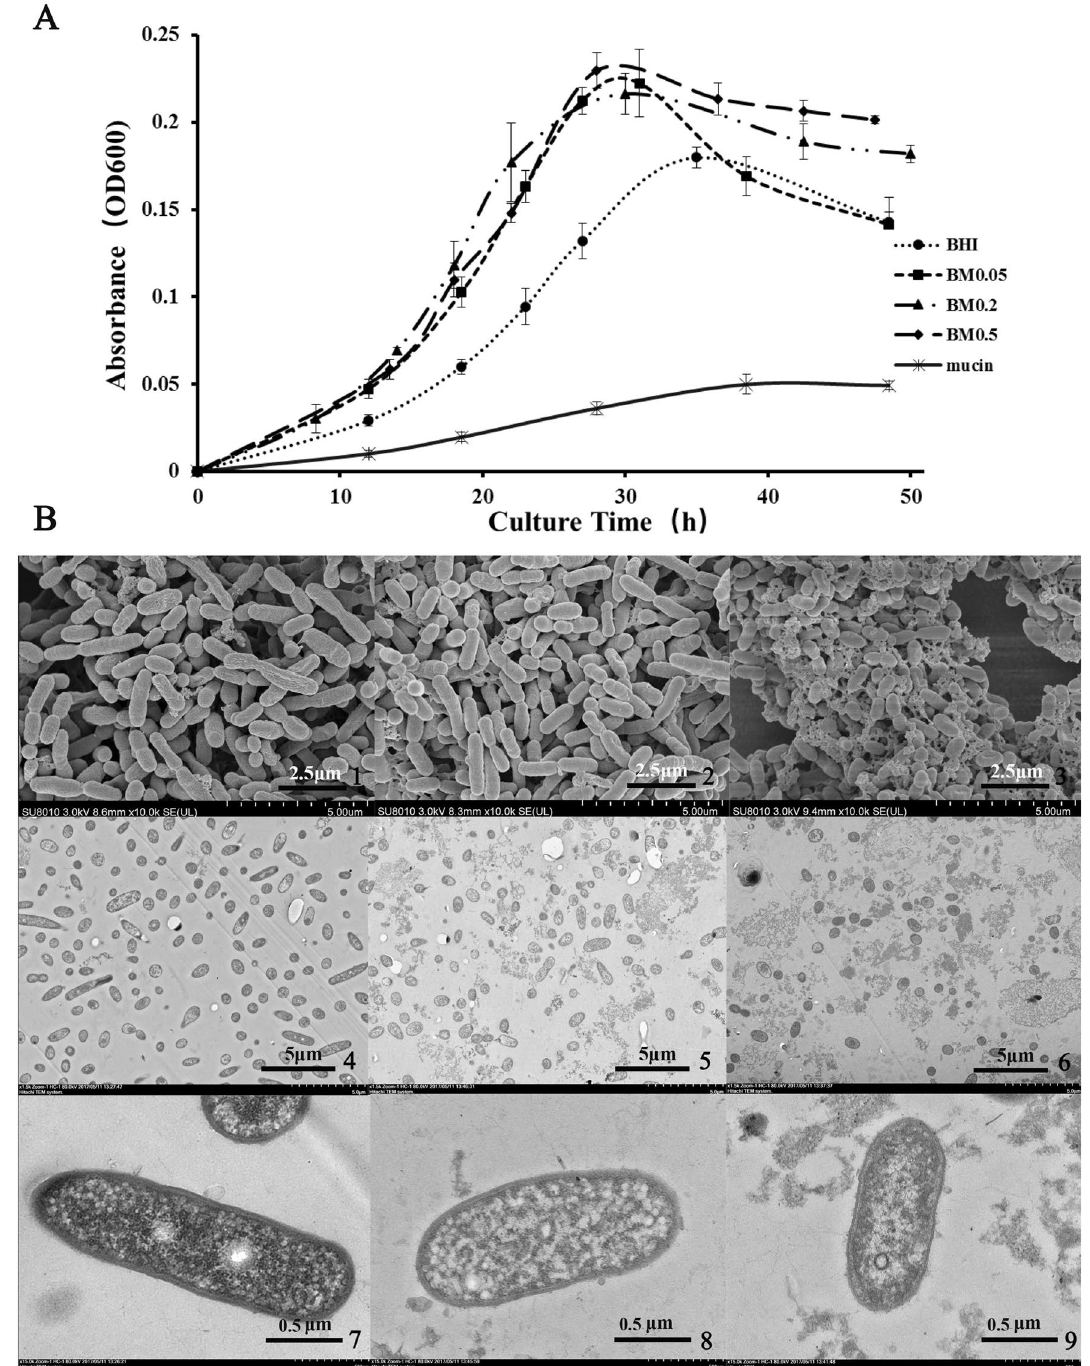
Figure 1. Mucin-dependent changes of A. muciniphila . ( A ) Growth curves; ( B ) Scanning and transmission electron microscopy images of A. muciniphila growing in BHI, BM0.05 and BM0.5, respectively. Among them, numbers 1, 4 and 7 represent groups without mucin; numbers 2, 5 and 8 represent groups with 0.05% mucin; numbers 3, 6 and 9 represent groups with 0.5%